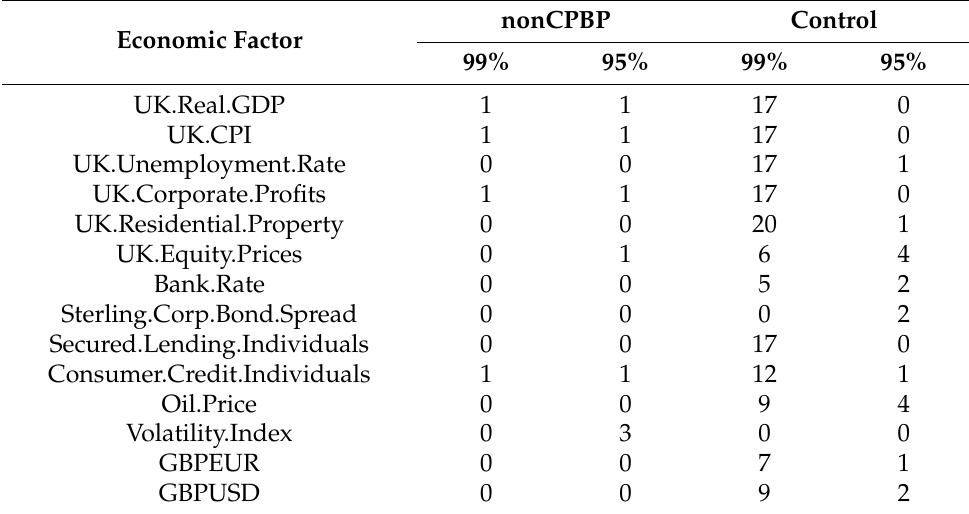
Table 6. Number of significant 5-year rolling window correlations at significance levels 99% and 95%: nonCPBP data and economic factors. There are few severity correlations but many frequency correlations.